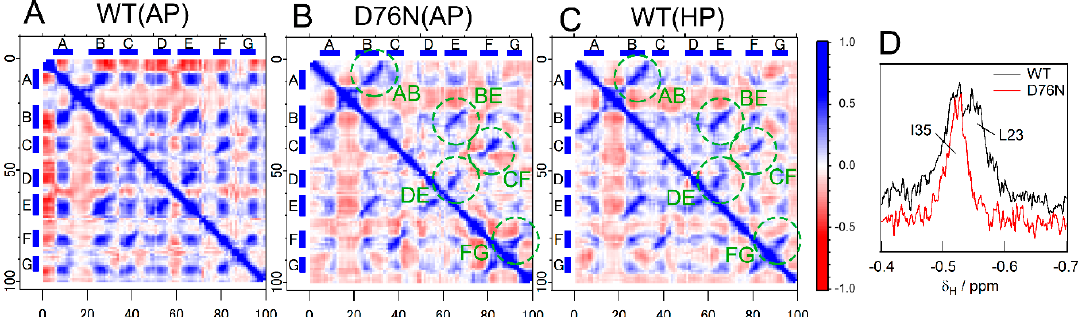
Figure 7. Assessment of inter-sheet packing. ( A – C ) Dynamic cross correlation matrices (DCCMs) calculated from MD results executed under conditions WT(AP) ( A ), D76N(AP) ( B ), and WT(HP) ( C ). The blue and red dots mean positively and negatively correlated motions, respectively, between the corresponding residues. ( D ) 1D 1 H NMR data as a probe for inter-sheet packing. The black and red lines are the 1D 1 H NMR spectra of WT and D76N at a high-field region, respectively.